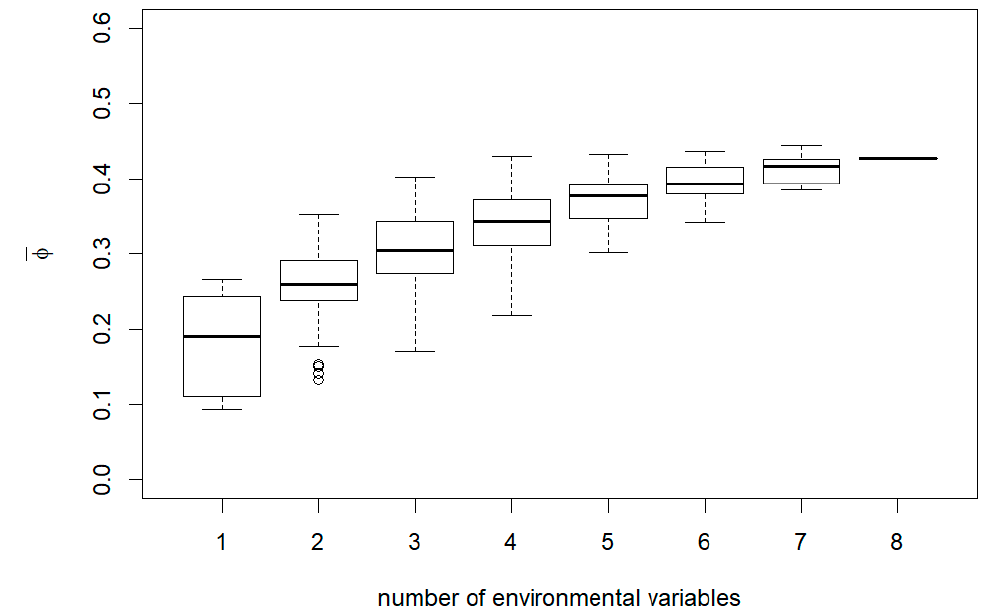
Figure A6. Box plot of mean phi coefficients ( φ ) of the FDMs generated by QDA as affected by the number of explanatory variables. Box plot shows median plus upper and lower quartiles for φ of FDMs with a given number of explanatory variables. Minimum and maximum values are indicated by the upper and lower whiskers (1.5 × interquartile range). Circles are outliers.